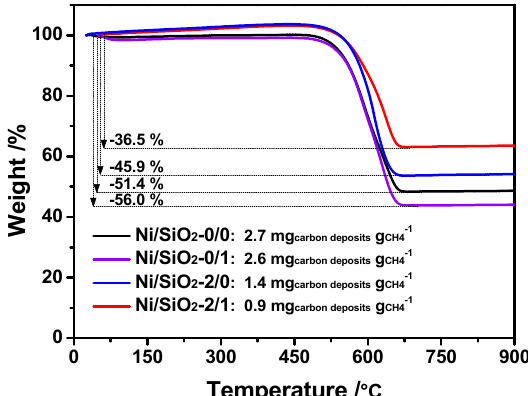
Figure 3. TG patterns of spent Ni/SiO 2 catalysts after the dry reforming (DRM) reaction of 50 hours. The catalytic results are shown in Figure 2.